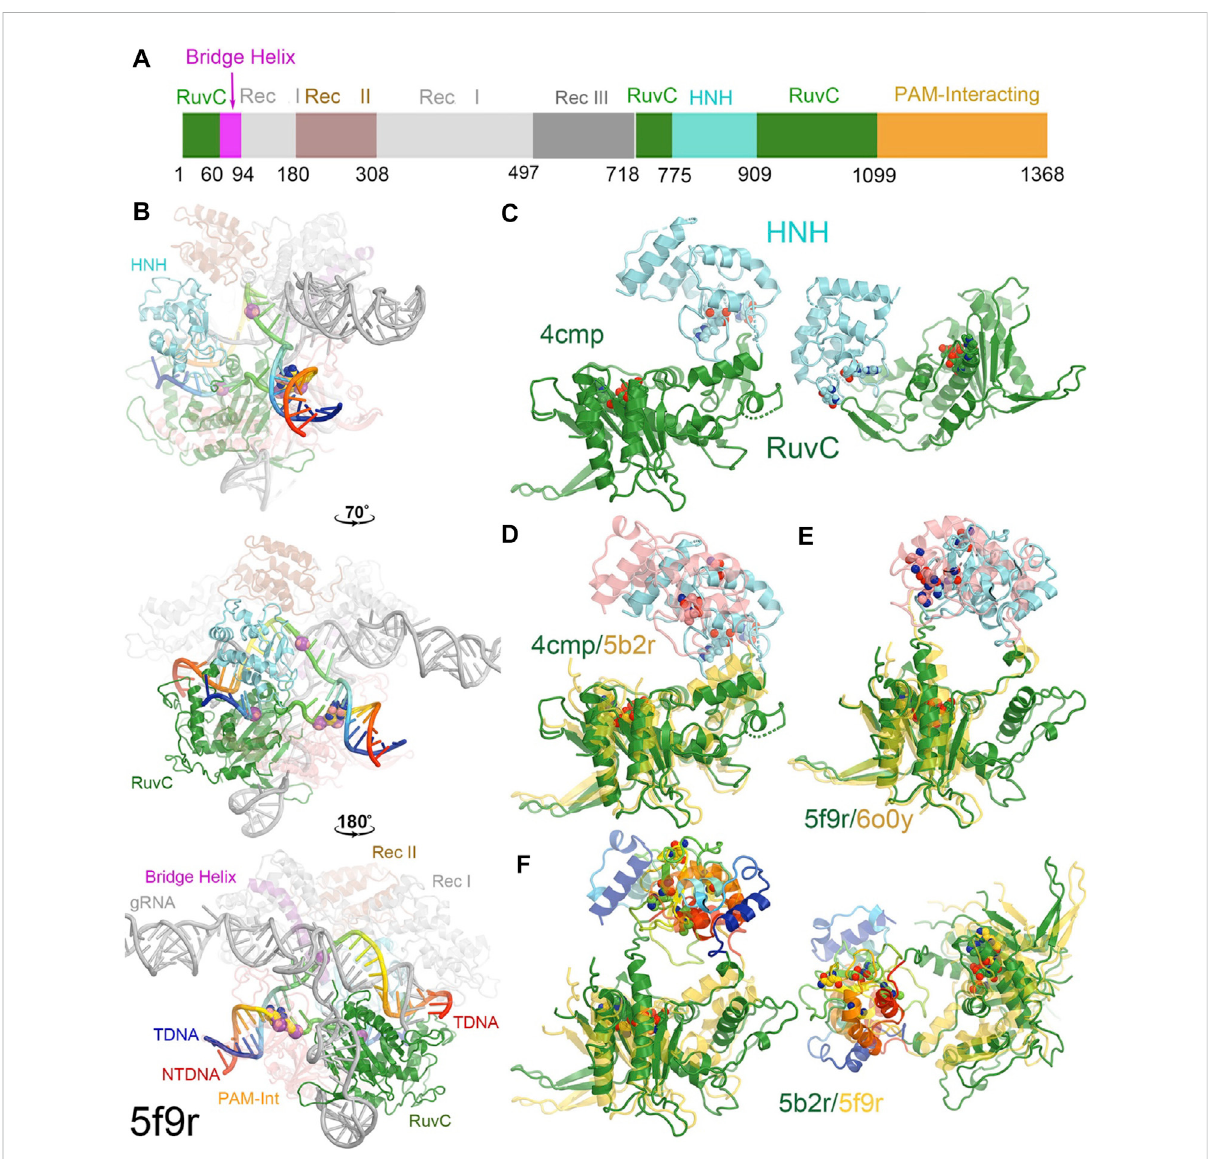
FIGURE 1 OverallstructureofaRuvC-catalyticallyrelevantCas9complex. (A) Linearstructures withcolorcodeddomains. (B) Threedifferentorientations of the5f9r complex with successive rotations of about 70 ° and 180 ° along thevertical axis. Two strands of the DNAduplexare in rainbow colors, and gRNAisingrey.TwoPAMnucleotidesareinlargeballs-and-sticks.ScissilephosphatesforboththetDNAandntDNAstrandsarerepresentedbylarge spheres. (C) Two views of the RuvC-HNH domains. (D) Superposition of the RuvC-HNH domains between the apo-4cmp and the catalytically inactive 5b2r structures. (E) Superposition of the catalytically relevant complexes of 5f9r and 6o0y. (F) Two views of the catalytically inactive and catalytically relevant complexes of 5b2r and